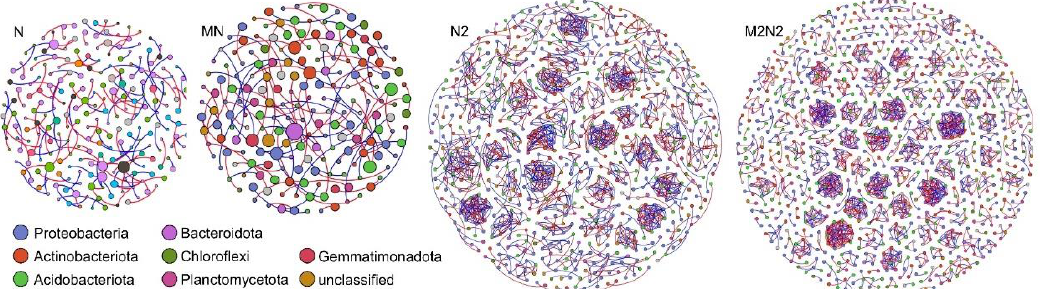
Figure 3. Network co-occurrence analysis of the bacterial communities within each fertilization treatment. A connection stands for a strong (Spearman’s R > 0.91) and significant ( p -value < 0.001) correlation. The size of each node is proportional to the number of connections (that is, degree).